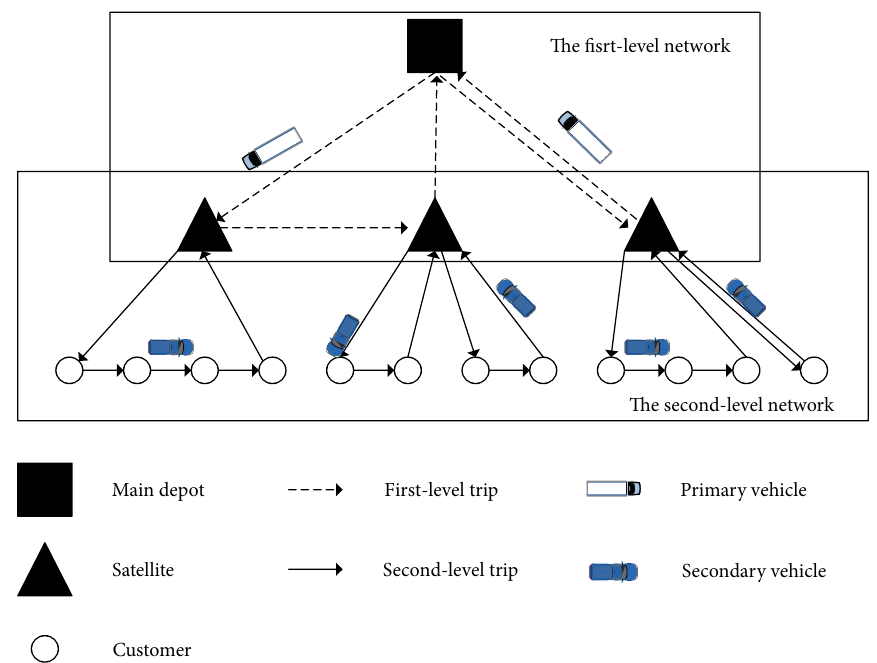
Figure 1: Representation of traditional